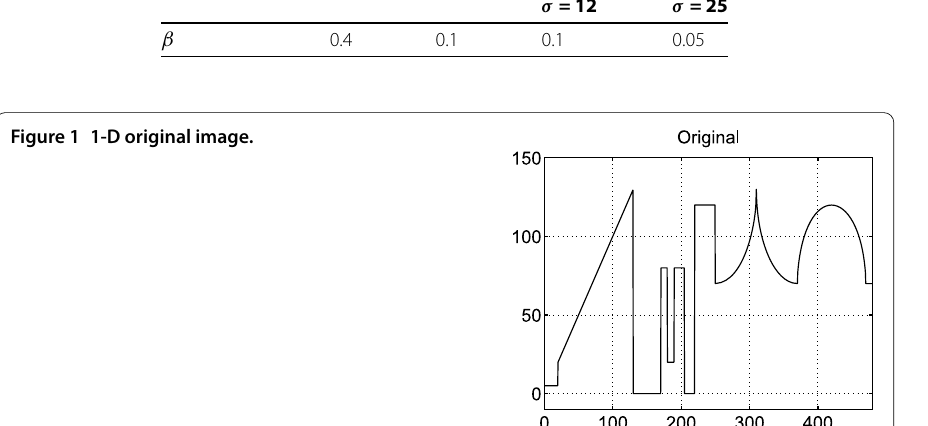
Table 1 Values of the parameter β Dimension